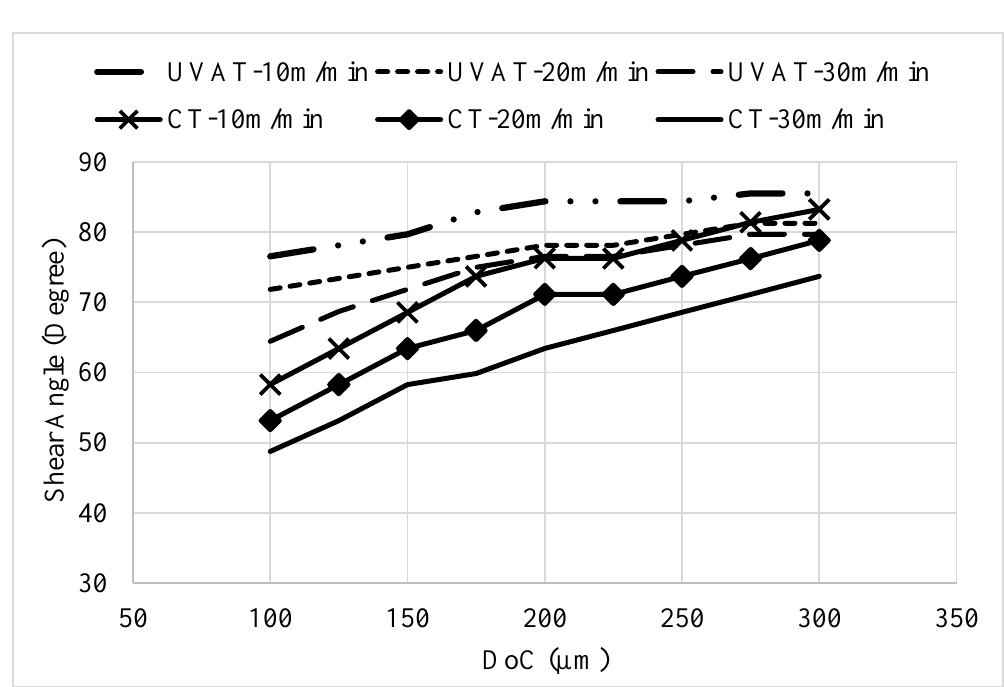
Figure 9. Predicted level of CCR in UVAT and CT.